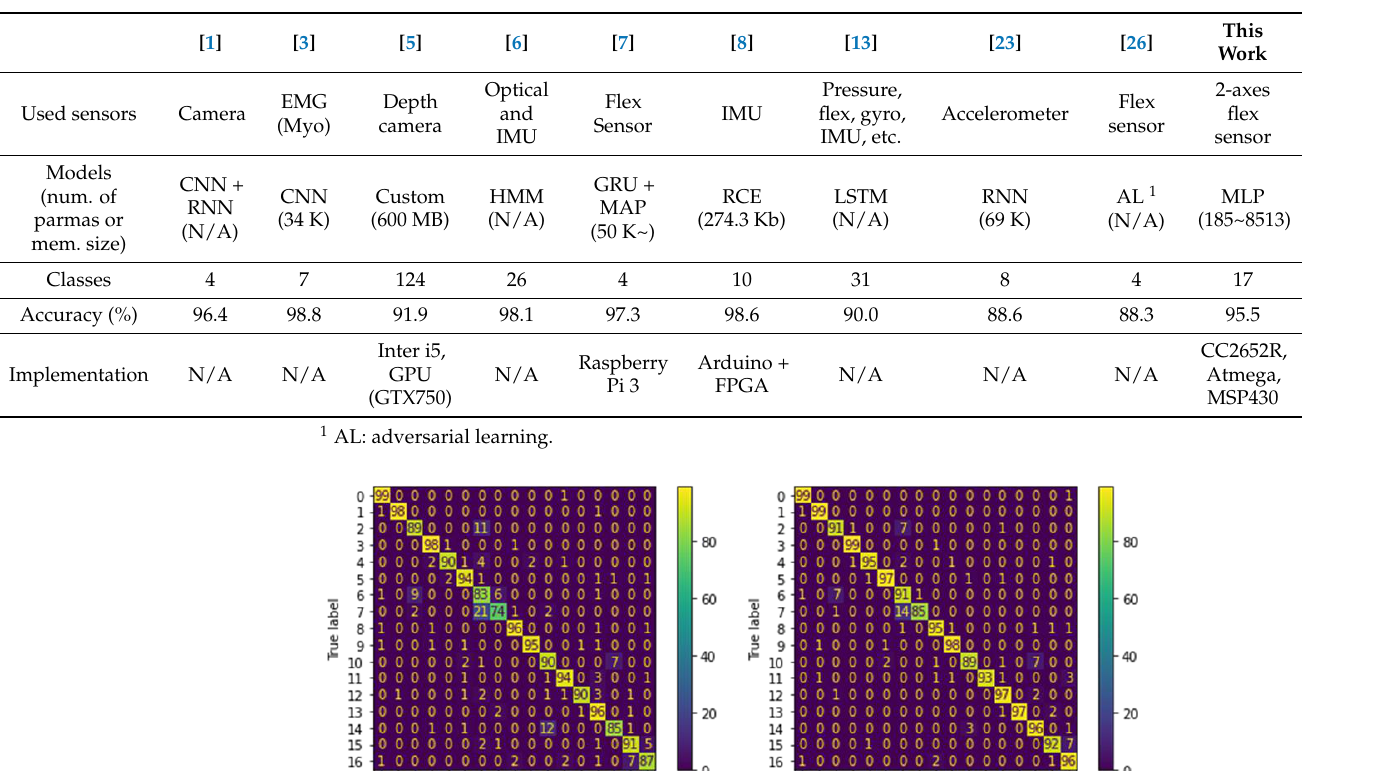
Table 4. Comparisons of existing hand gesture recognition studies.